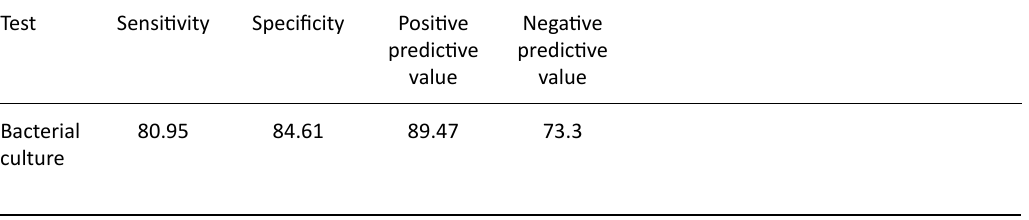
Table 2. Sensitivity, Specificity, Positive predictive value and Negative predictive value of bacterial culture